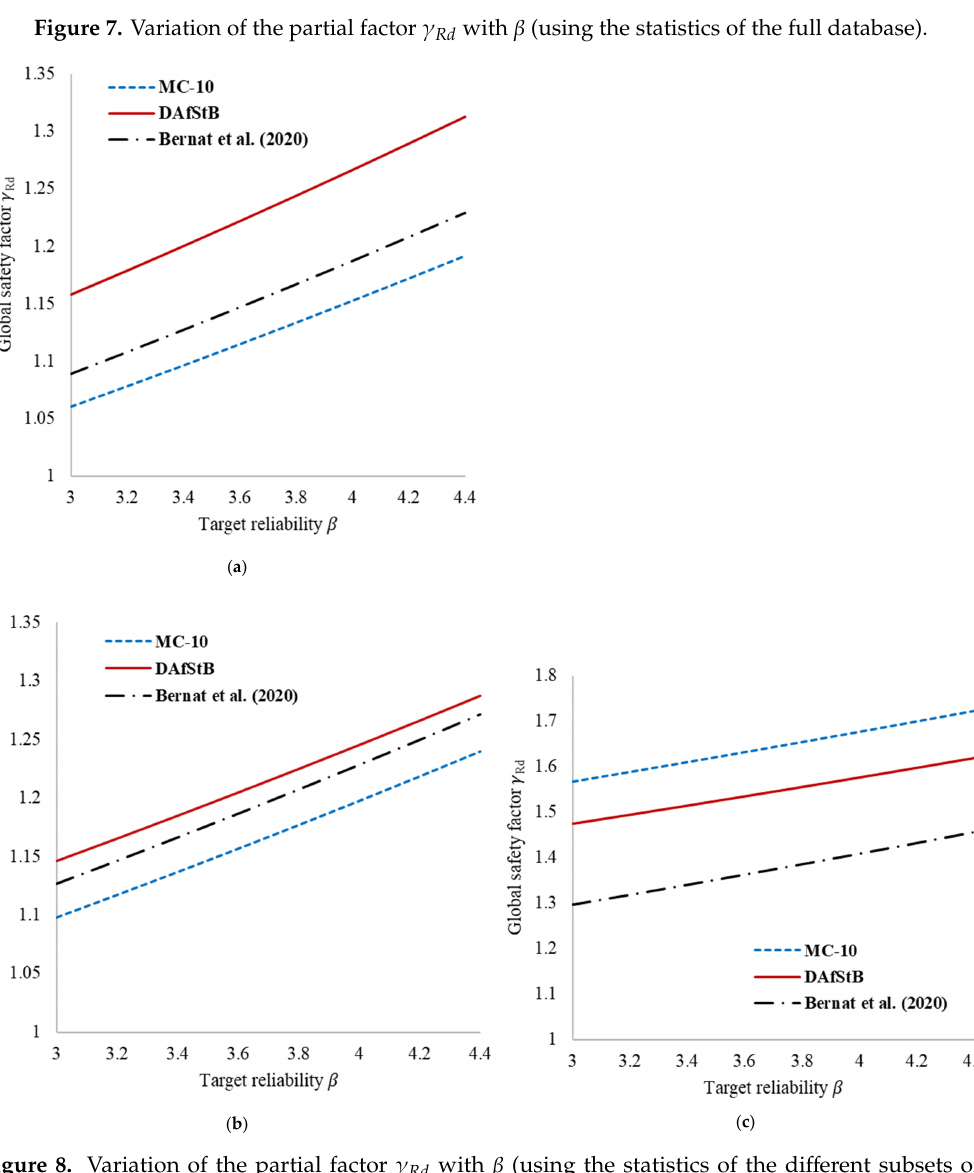
Figure 8. Variation of the partial factor γ Rd with β (using the statistics of the di ff erent subsets of shear span to e ff ective depth ratio). ( a ) Short shear span length. ( b ) Medium shear span length. ( c ) Slender shear span